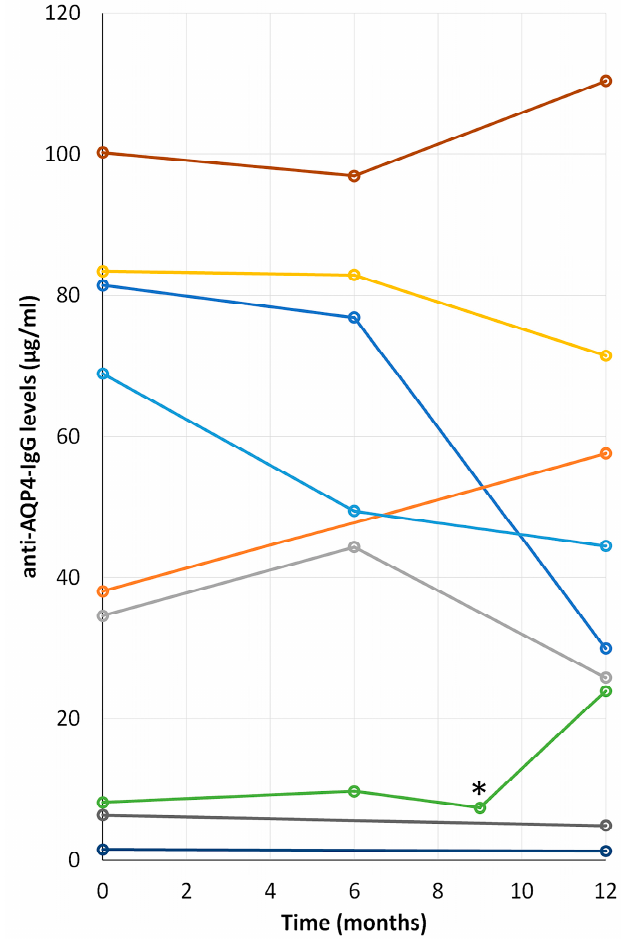
Figure 4. Time course progression of anti-AQP4-IgG levels in NMOsd( + ) patients. Levels of IgG-anti-AQP4 in serum of 9 patients along a period of 12 months. *, sample obtained in a crisis or clinical episode.